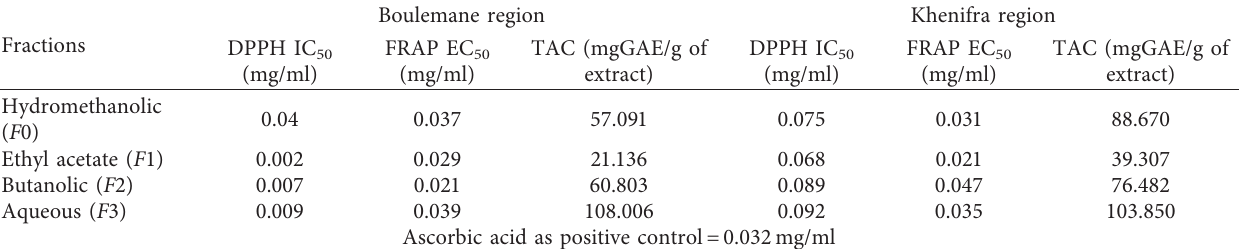
Table 2: Antioxidant activity of the hydromethanolic extract ( F 0) and its fractions ( F 1, F 2, and F 3) of Salvia officinalis .